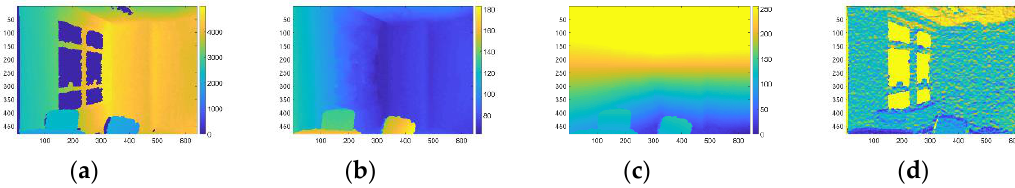
Figure 5. Examples of depth encoding. ( a ) Raw depth image, ( b ) the horizontal disparity, ( c ) the height above ground, ( d ) the angle with gravity.